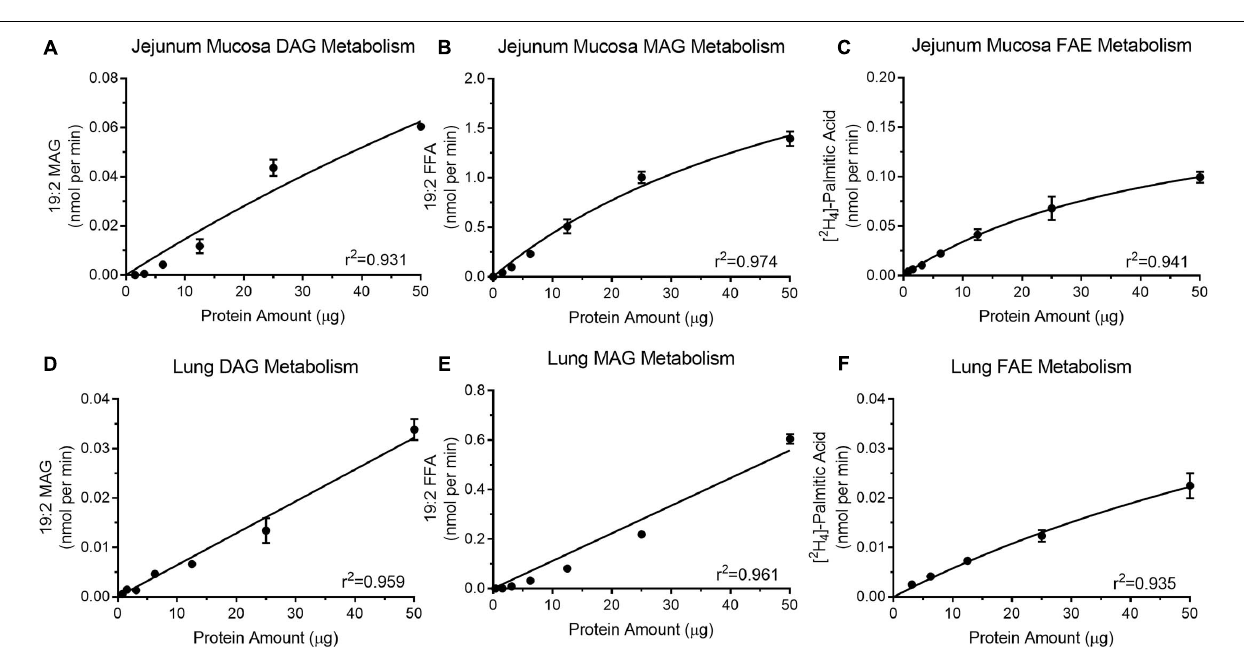
FIGURE 3 | Isolated protein from mouse jejunum mucosa display increases in product recovery as protein amount increases for DGL activity (A) , MGL activity (B) , and FAAH (C) . Mouse lung protein isolates exhibit increases in product recovery as the amount of protein increased for DGL (D) , MGL (E) , and FAAH (F)